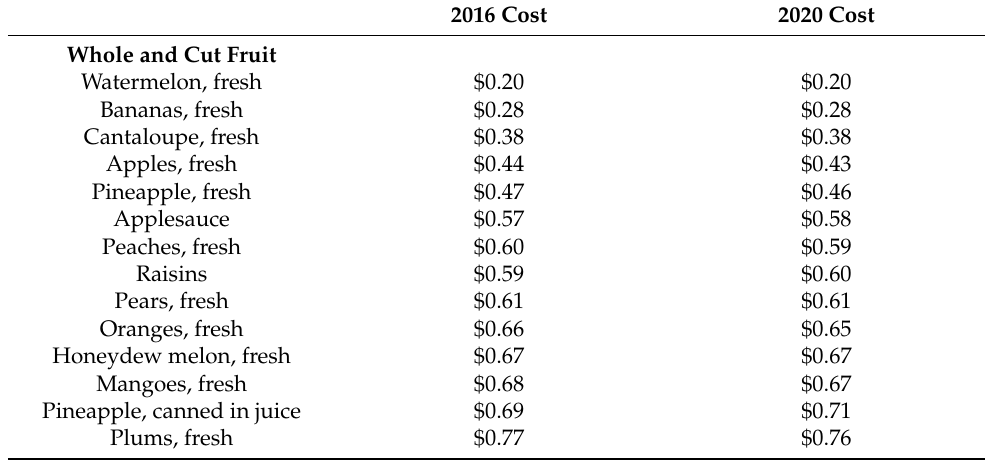
Table 1. Costs of selected fruit per cup-equivalent, 2016 and